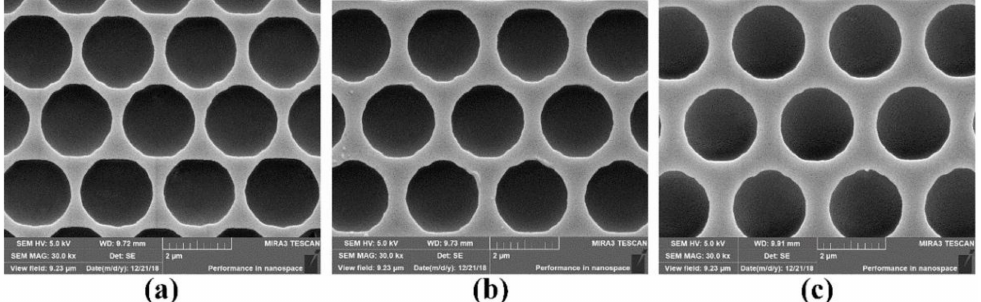
Figure 4. Top-view SEM images of the pinhole patterns with different intervals: ( a ) 400 nm; ( b ) 600 nm; ( c ) 800